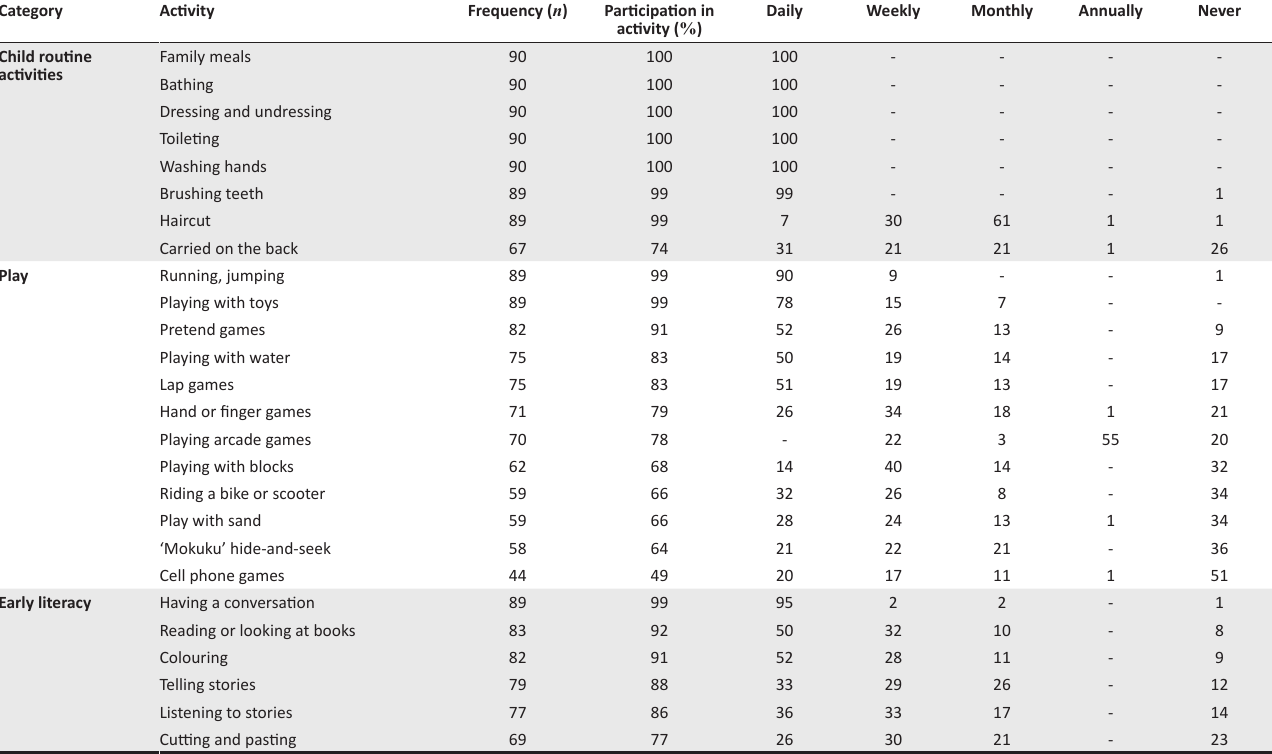
TABLE 1: Frequency of participation ( n = 90).